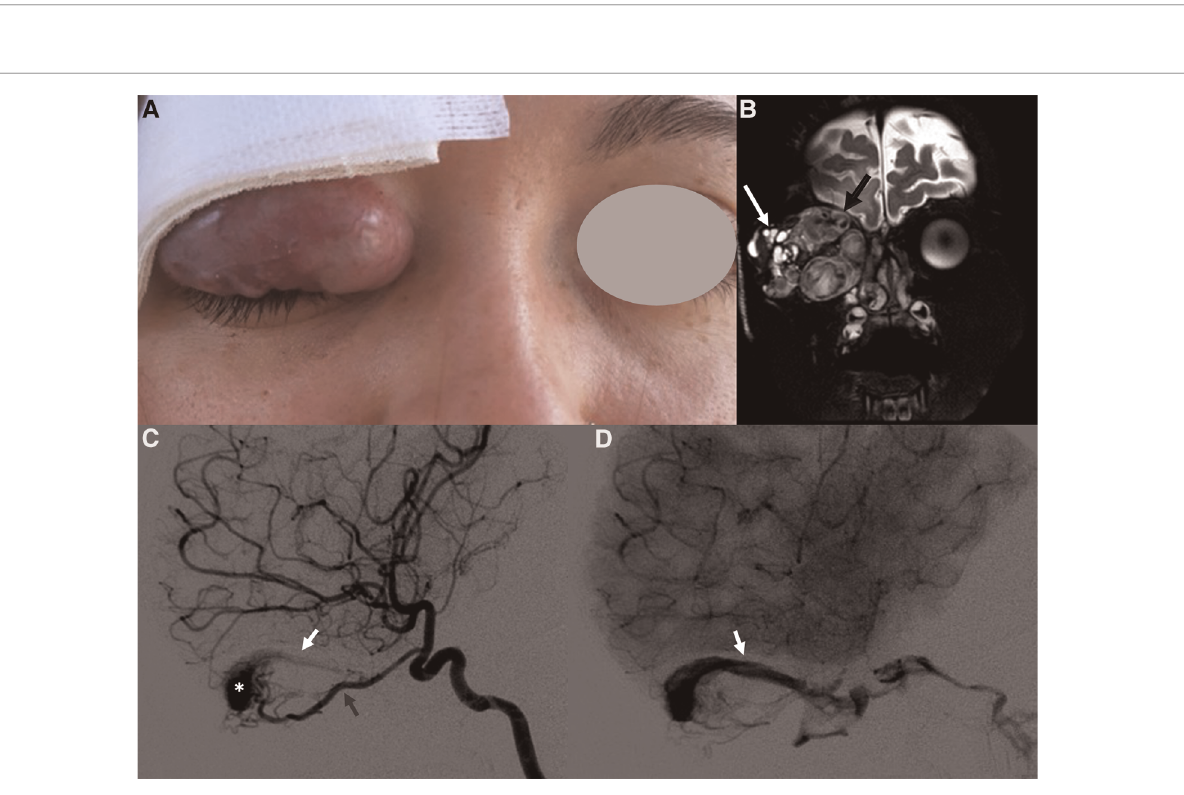
FIGURE 12 Right orbital AVM in a 14-year-old girl with progressive proptosis, strabismus and visual loss. A red pulsatile mass in the upper lid was already evident at clinical examination ( A ); a thrill was also perceptible at palpation. Coronal T2 TSE sequence ( B ) shows a massive trans-spatial expansile lesion occupying the entire orbit, distorting its anatomy; signal intensity is highly inhomogeneous due to the presence of tortuous fl ow-voids (black arrow in B ) and blood products of varying age (white arrow in B ). The other MR sequences did not demonstrate any intracranial extension of the vascular malformation (not shown). The arterial phase of the DSA (lateral view, C ) depicts the dilated and slightly tortuous right ophthalmic artery (grey arrowhead, arising from the supraclinoid segment of the internal carotid artery) feeding the orbital AVM, the nidus (white asterisk) and the early opaci fi cation of the draining vein, the superior ophthalmic vein (white arrowhead). The venous drainage is better seen in the venous phase of the DSA (lateral view, D ), occurring mainly through the dilated right superior ophthalmic vein (white arrowhead), which drains into the cavernous